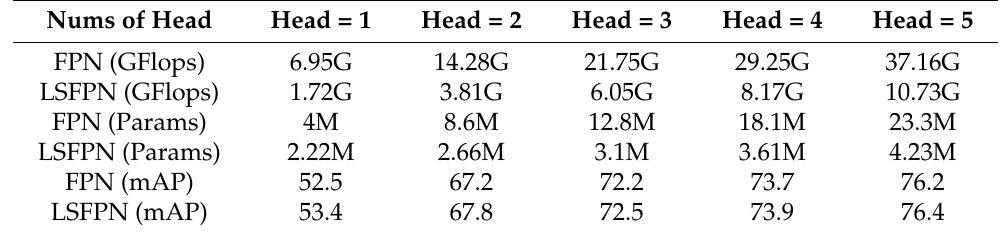
Table 5. Analysis of LSFPN’s computation and parameter amount under multiple detection